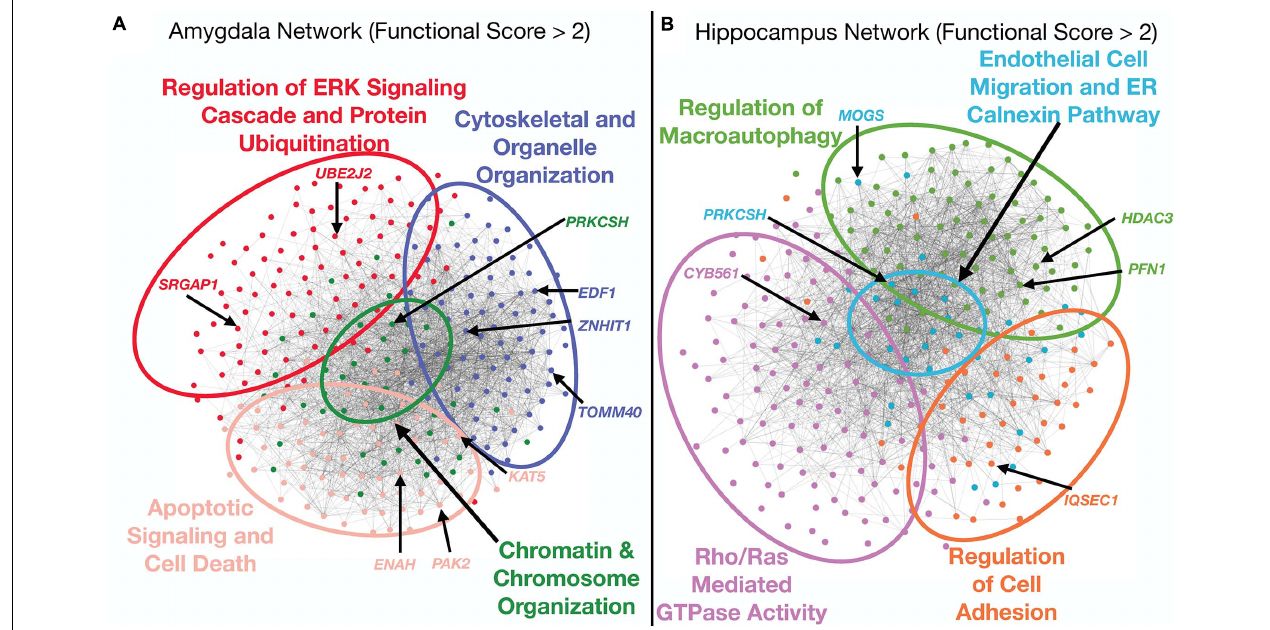
FIGURE 3 | Analysis of top functional subnetworks. The functional subnetwork of genes with a functional scores greater than 2 were extracted from both tissue networks, run through a modularity algorithm, and the modules were functionally annotated using functional enrichment analysis by g:OSt. Several of the top hit genes from the combined ranking appeared in a diverse array of functional classifications. Each gene is colored by the functional module in which it is a member. Network edges were filtered to only include weights greater than 0.25 for visual clarity. (A) Amygdala sub-network analysis. The top functional sub-network for this tissue was enriched for genes in pathways that regulate apoptosis and cell death, cytoskeletal and organelle organization and chromosomal organization. (B) Hippocampus sub-network analysis. This top functional sub-network was enriched for genes involved in immune signaling as well as cell adhesion and ER